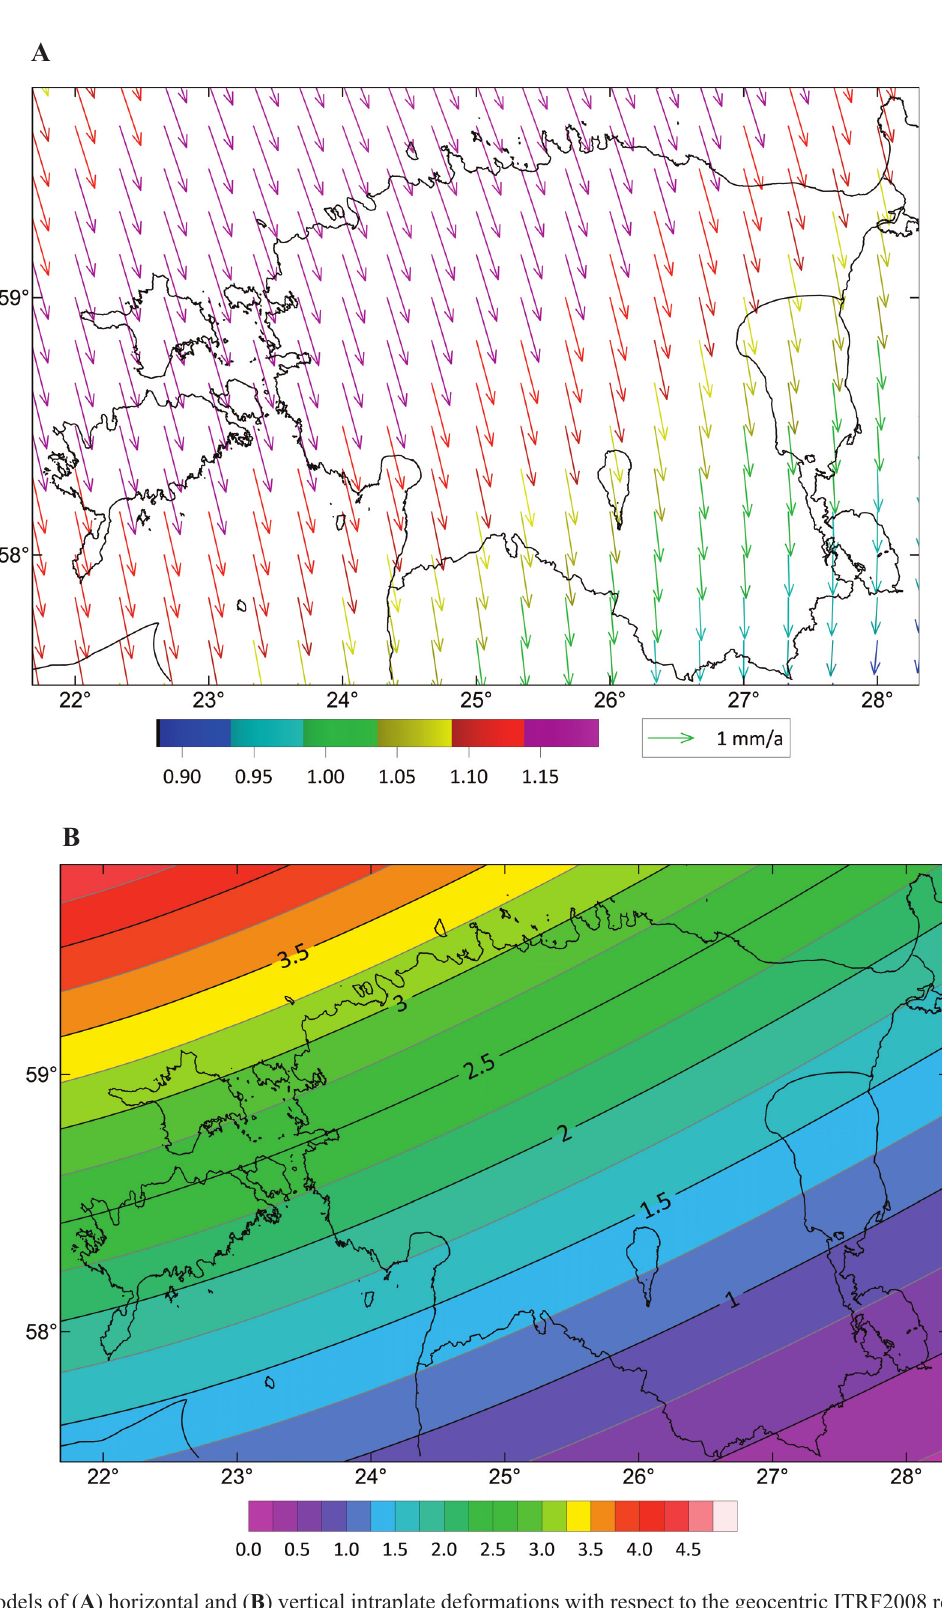
Fig. 10. Models of ( A ) horizontal and ( B ) vertical intraplate deformations with respect to the geocentric ITRF2008 reference frame. 2D vectors represent horizontal velocities where the colour of the vector represents the magnitude of the movement. Velocities of the Eurasian plate are removed using the ITRF2008-PMM model (Altamimi et al. 2012). All units are